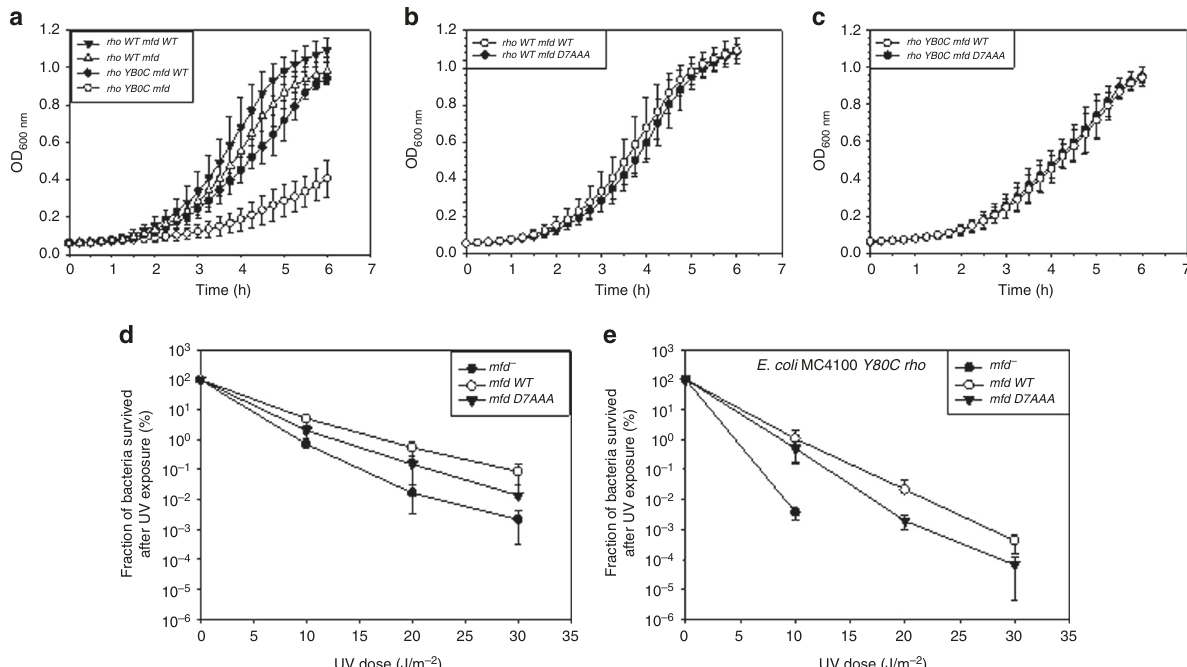
Fig. 4 Combinatorial effects of the Rho mutants and either the Mfd deletion or the Mfd mutant. a Growth comparison of E. coli MC4100 carrying WT or mutant (Y80C) Rho in the presence or absence of the mfd . In combination with rho Y80C, the deletion of mfd , induces severe slowing down of the bacterial growth. b and c are showing the growth curves of MC4100 WT rho and MC4100 Y80C rho strains expressing Mfd D7AAA. The mutant Mfd suppressed the growth defects of Δ mfd strain. d and e UV sensitivity of E. coli MC4100 WT rho and MC4100 Y80C rho strains having the mfd mutations or deletions as indicated. Δ mfd strains were highly sensitive to the UV doses whereas the strain expressing the Mfd D7AAA showed a moderate sensitivity as compared to the WT Mfd. Error bars were calculated from the standard deviation obtained from at least three independent measurements. Source data are provided as a Source Data fi